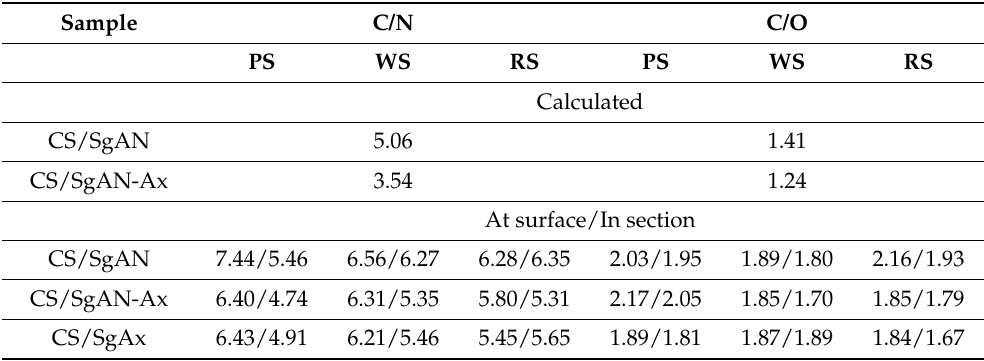
Table 2. The C/N and C/O atomic ratios calculated and determined by EDAX for composite beads.